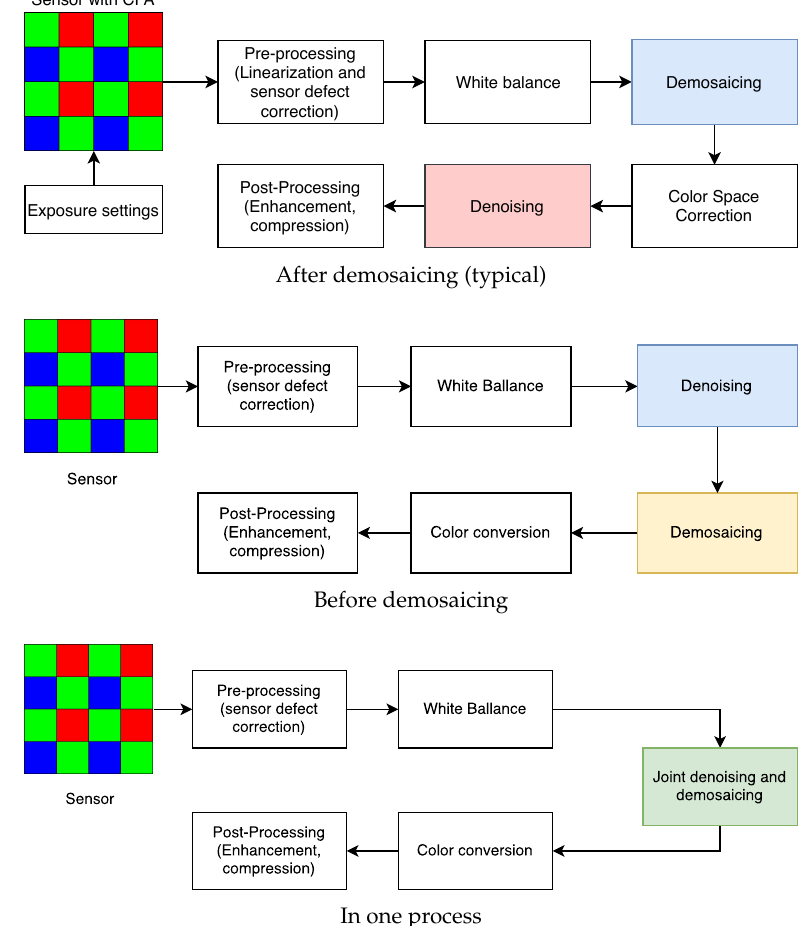
Figure 3. Variants of raw image processing pipelines—placement of denoising algorithms.